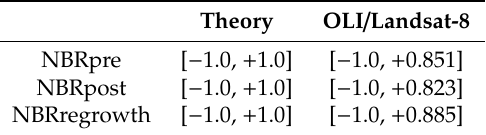
fire in Gerais do Machobongo.